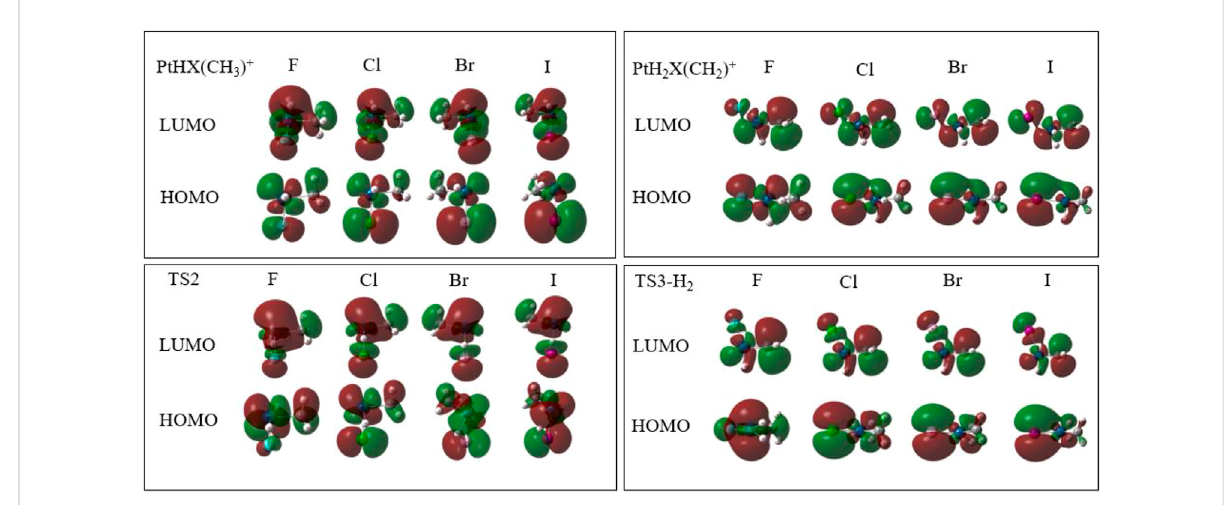
FIGURE 5 HOMO/LUMO orbital graphs in part of the structures of rate controlling step in the reaction of PtX + (X = F, Cl, Br, I) + CH 4 in the singlet state.